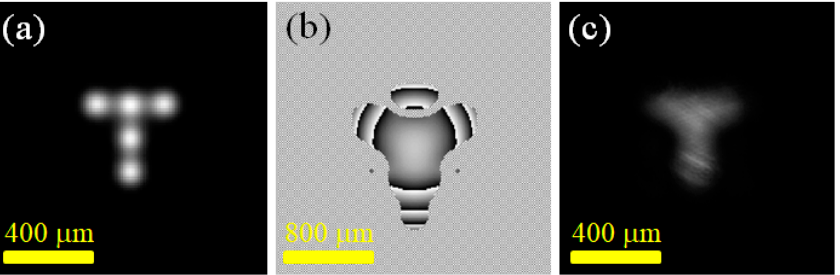
Figure 5. Experiments of generating a T-shaped laser light field: ( a ) the calculated 5-point light intensity; ( b ) the SLM projected phase diagram; ( c ) the resulting laser light field distributions.